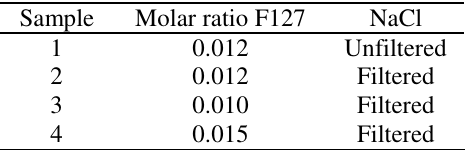
Table 1. Synthetic conditions and molar ratio for different samples. The molar ratios for the phenol (65.0 mmol), formaldehyde (130.0 mmol) and NaOH (6.5 mmol) by keeping the same in all samples while the ratios of F127 are different Sample Molar ratio F127 NaCl 1 0.012 Unfiltered Filtered